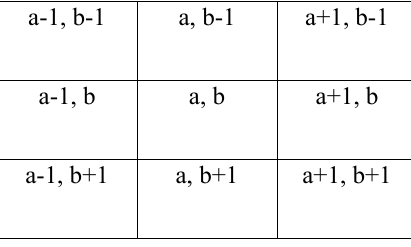
Figure 5. Connectivity of pixel (a,